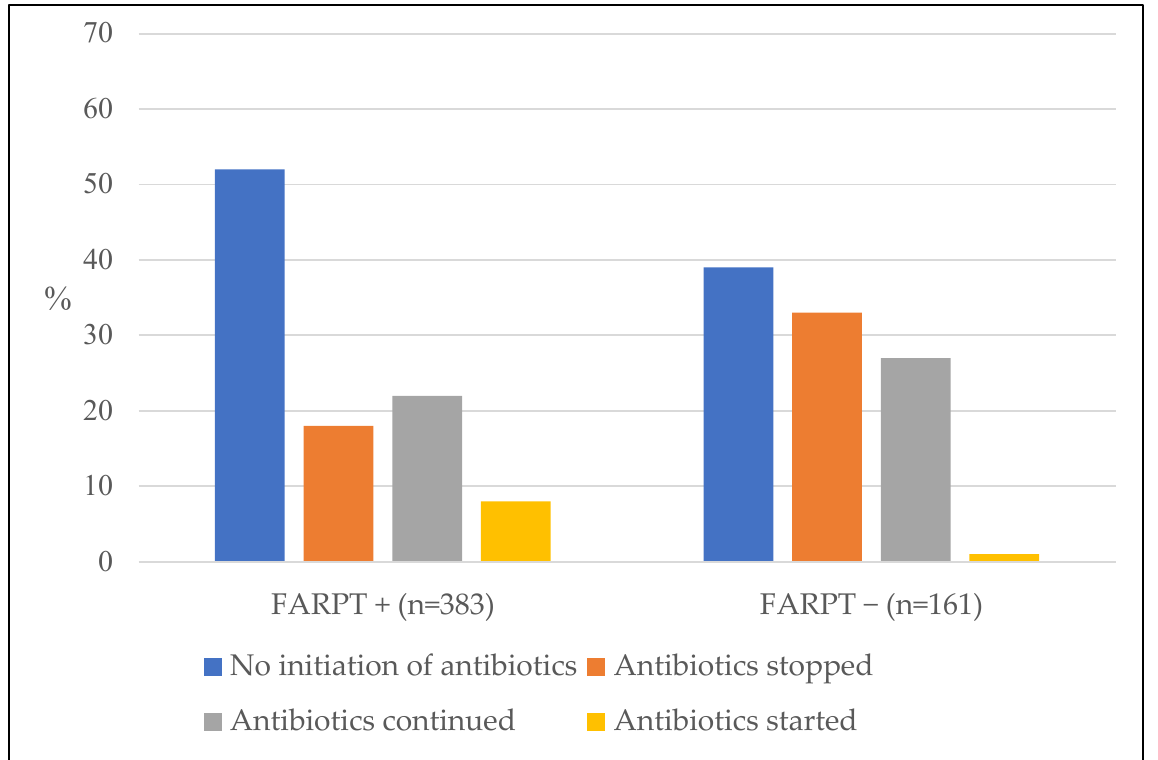
Figure 2. In fl uence of viral identi fi cation with the FilmArray ® Respiratory Panel test in the manage- Figure 2. Influence of viral identification with the FilmArray ® Respiratory Panel test in the manage- ment of post-test antibiotic therapy (n = 544 tests). ment of post-test antibiotic therapy (n = 544